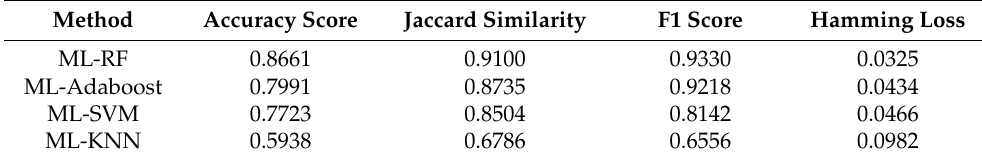
Table 2. Scenario 1: comparison with other methods.